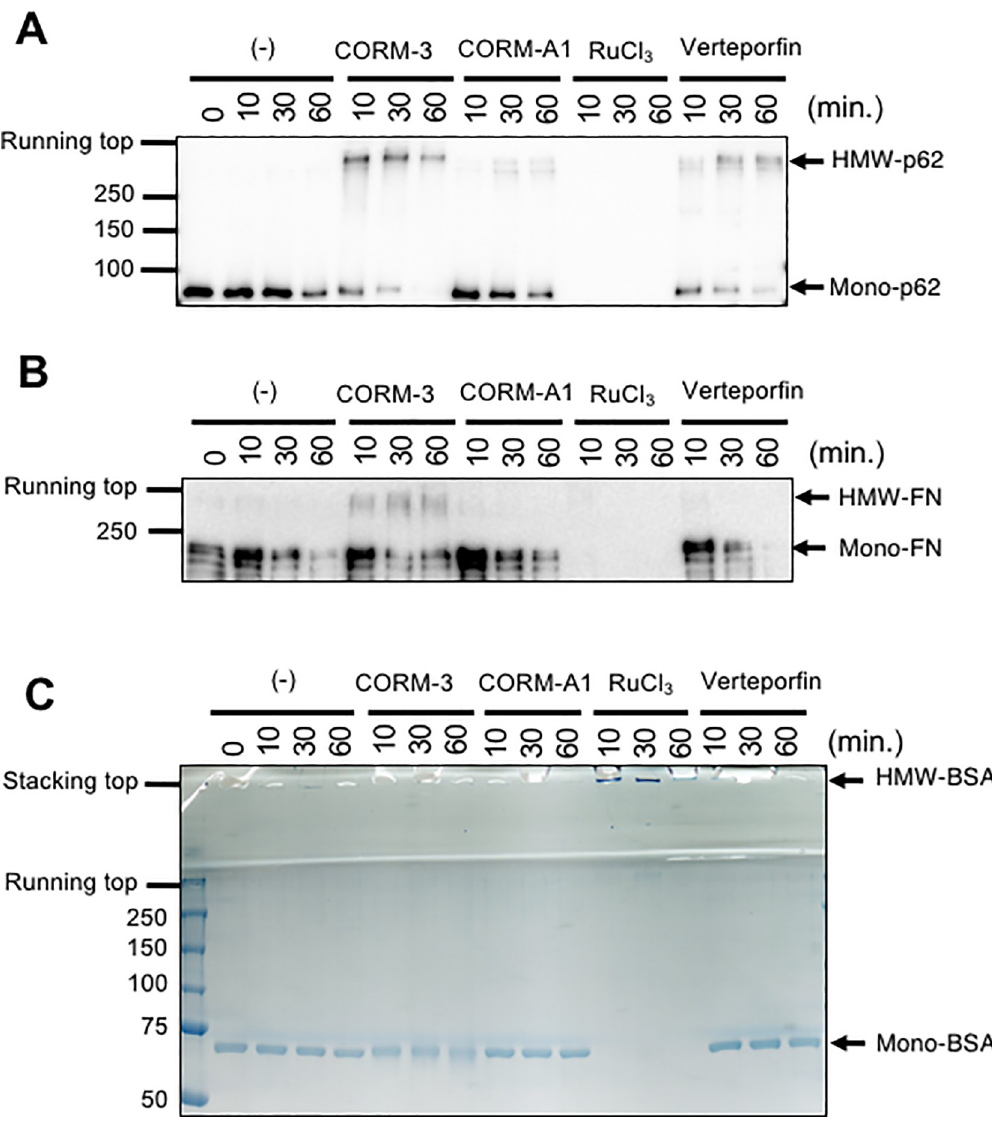
Fig 5. Production of HMW-p62 by CORM-3 in vitro . Purified recombinant full-length human p62 (A), bovine plasma fibronectin (FN) (B), or bovine serum albumin (BSA) (C) was dissolved in PBS and treated with CORM-3 (1 mM), CORM-A1 (1 mM), or RuCl 3 (1 mM) for 0–60 min. p62, FN, and BSA were also treated with verteporfin (10 μ M) for 0- 60min. After SDS-PAGE, p62 and FN were visualized by immunoblot analysis while BSA was stained with